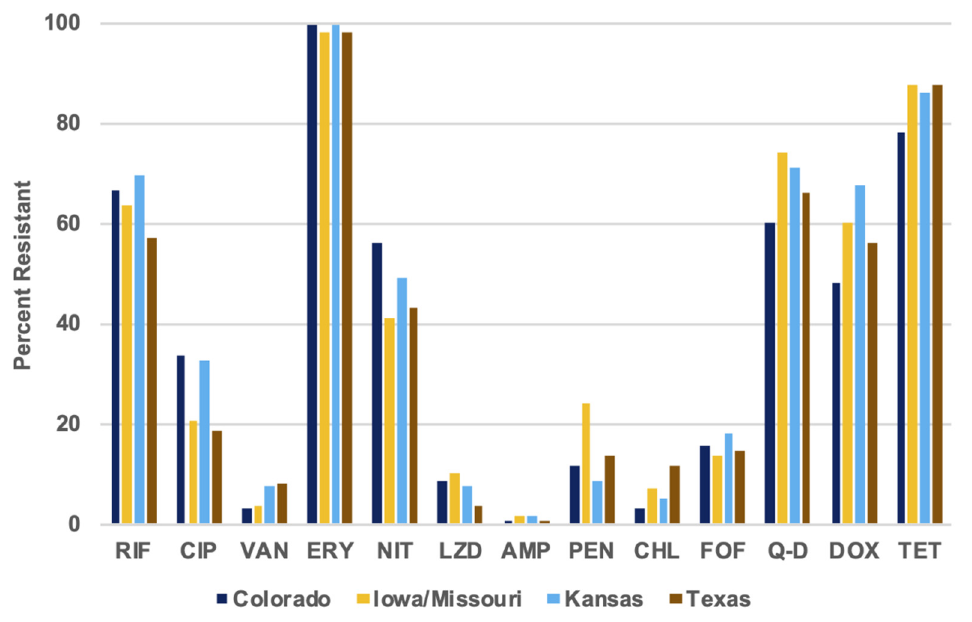
significant comparison in the panel were between Kansas and Texas, p = 0.019).